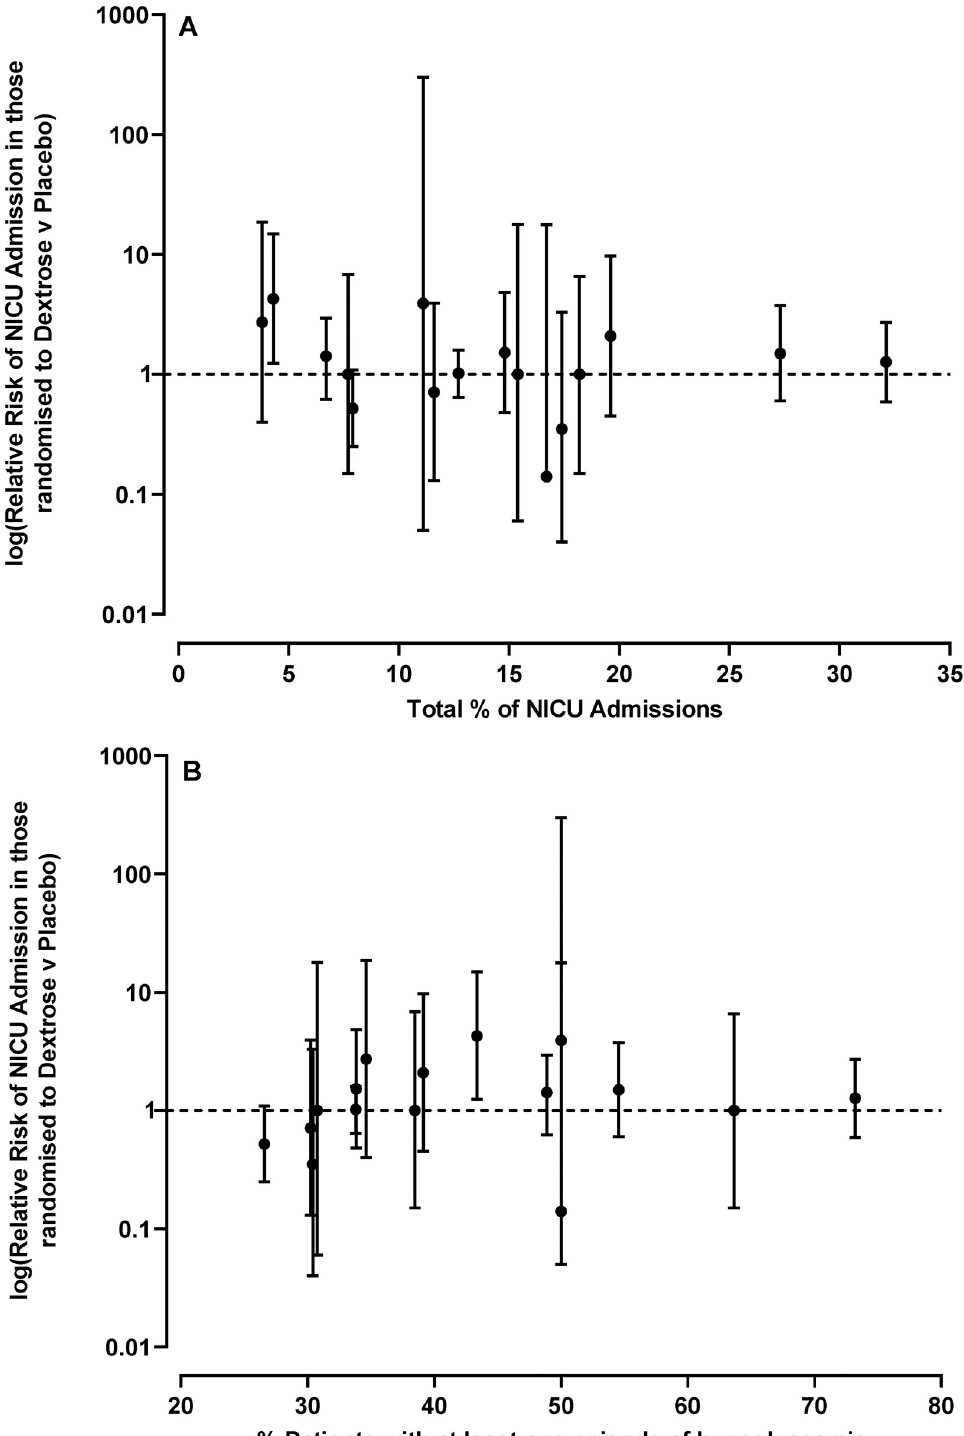
Fig 3. Relationship between the effect of dextrose gel on rate of neonatal intensive care unit (NICU) admission and rate of hypoglycemia in different study sites. (A) NICU admission; (B) hypoglycemia. Two study sites are excluded due to small numbers of babies